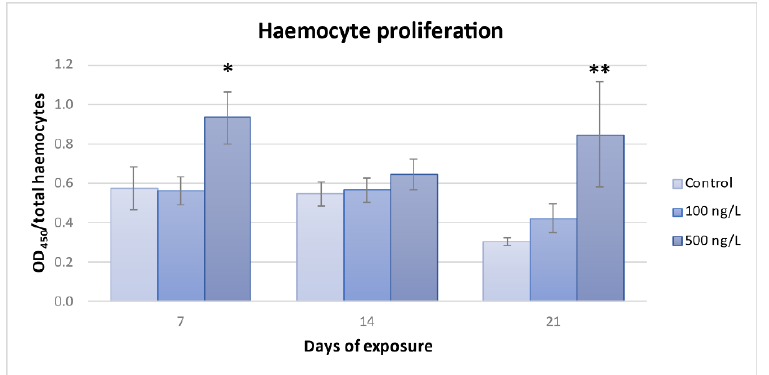
Figure 2. Haemocyte proliferation in Ruditapes philippinarum after exposure to 100 ng/L and 500 ng/L of HHCB for 7, 14 and 21 days. The results are expressed as OD 450 and are reported as means ± standard error; n = 6. Asterisks indicate significant differences compared to controls at the same time of exposure: * p < 0.05, ** p < 0.01.